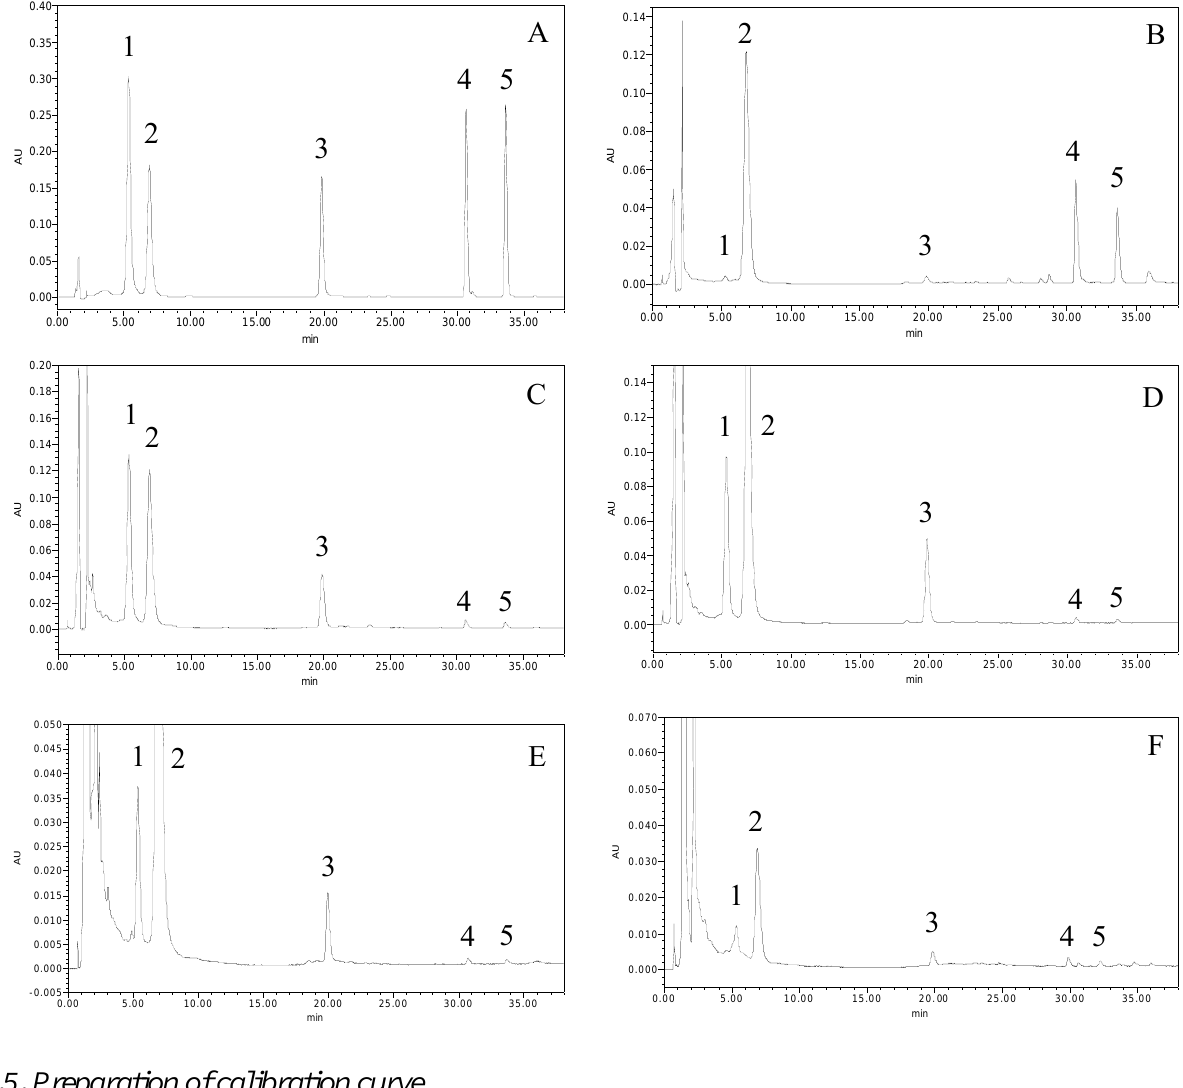
Figure 5. The HPLC chromatograms of the standard mixture solutions and samples. (A) standard mixture solutions, (B) peel, (C) pith, (D) endocarp, (E) pulp, (F) seed. Peaks 1, 2, 3, 4 and 5 correspond to naringin, hesperidin, didymin, tangeretin and nobiletin,